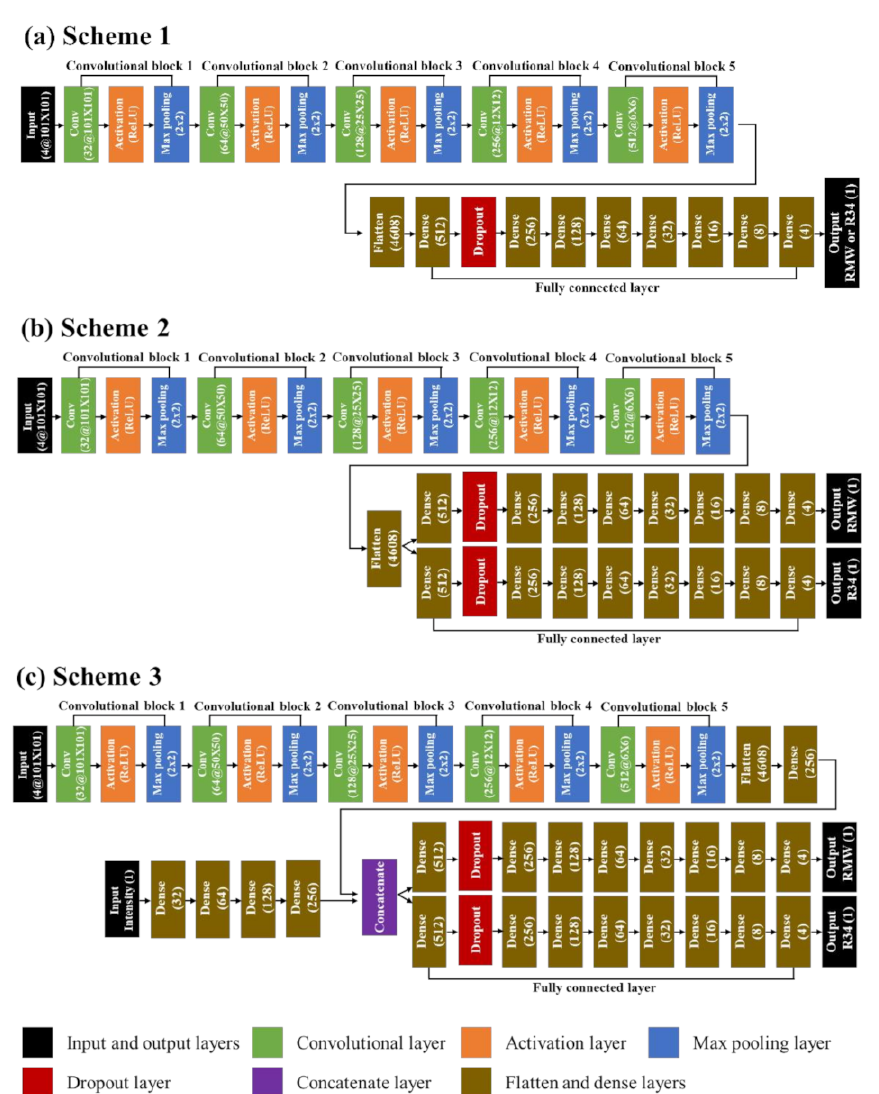
Figure 3. The architecture of the three CNN models used in this study: ( a ) a single-task model (Scheme 1), ( b ) a multi-task model (Scheme 2), and ( c ) a multi-task model using additional TC intensity information as input (Scheme 3). The numbers in parentheses indicate the number of filters, max pooling size, activation function, or data size in each